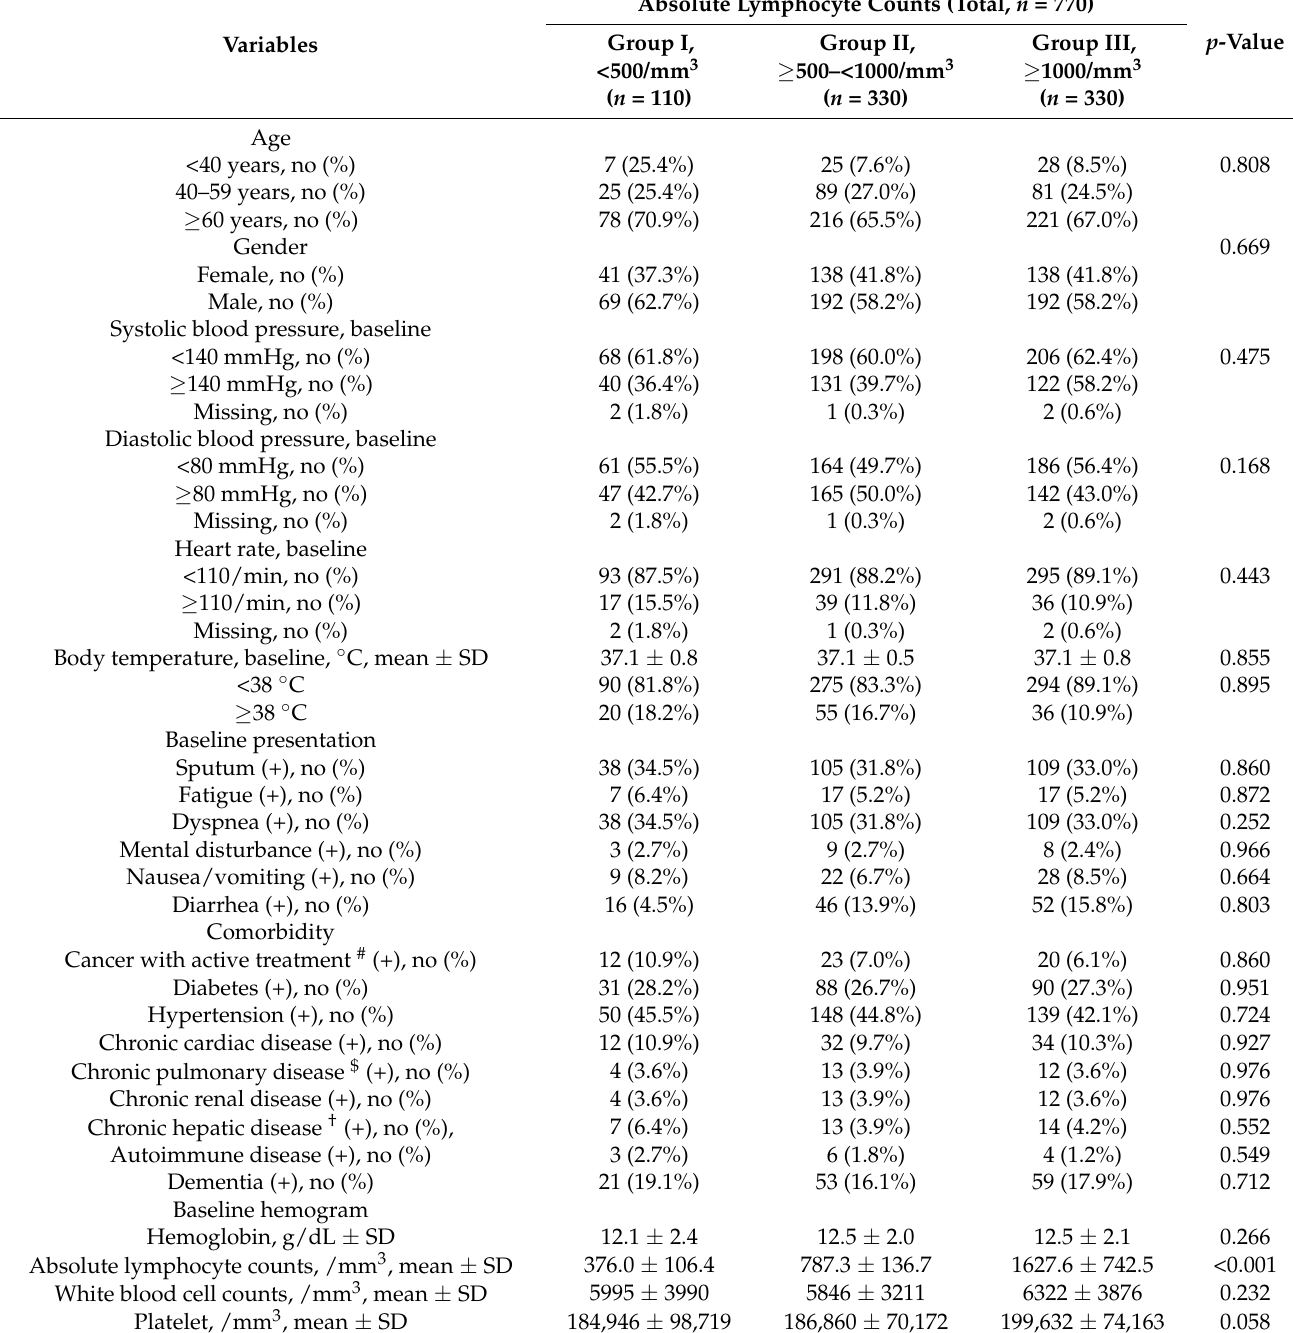
Table 2. Baseline demographic and clinical